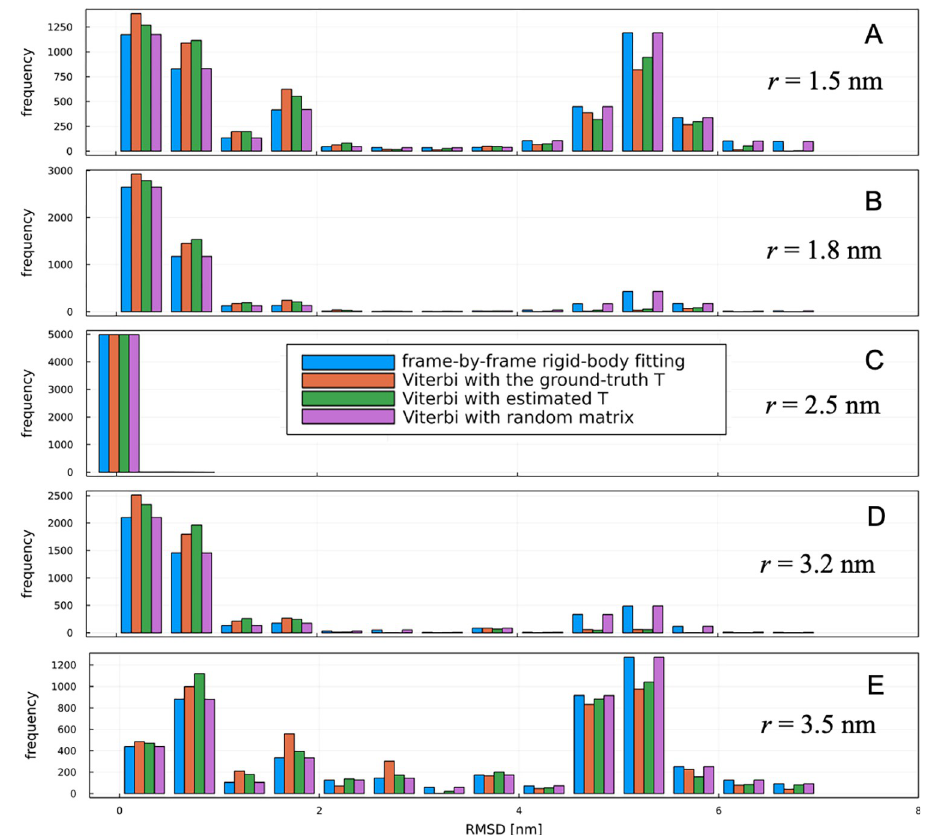
Fig 3. Results of twin experiments. Histograms of root-mean square deviations (RMSDs) of estimated structures from the ground-truth structures in twin experiments. Note that the RMSDs were computed without structural alignment. Structural estimations were performed with various conditions: with different algorithms (the frame-by- frame rigid-body fitting, the Viterbi algorithm using the ground-truth transition probabilities, estimated probabilities by the Baum-Welch algorithm, and a random matrix), and different tip radii (1.5 nm, 1.8 nm, 2.5 nm that is the ground-truth, 3.2 nm, 3.5